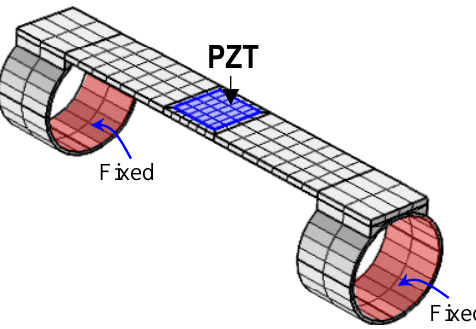
Figure 4. Finite element modeling of wearable PZT interface. Table 2. Mechanical properties of the steel interface body.